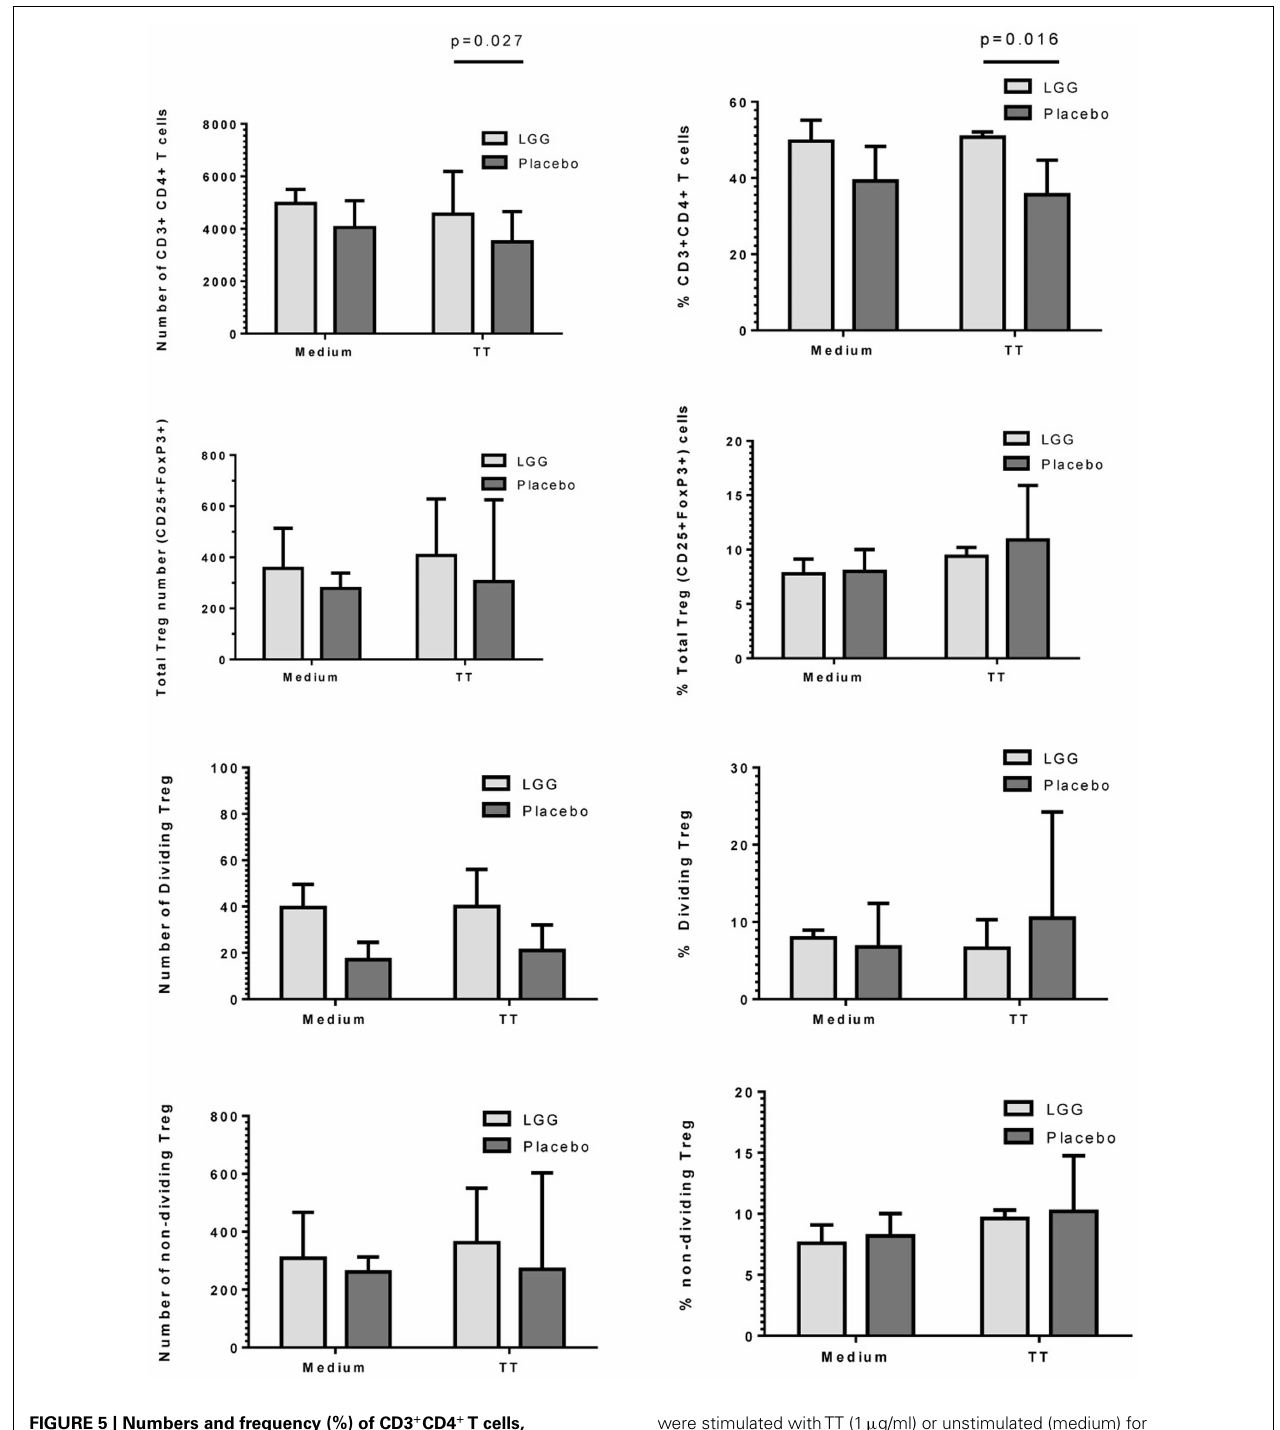
FIGURE 5 | Numbers and frequency (%) of CD3 + CD4 + T cells, total CD4 + CD25 + FoxP3 + Treg, dividing (CFSE lo ), and non-dividing (CFSE hi )Treg identified in PBMCs isolated from infants in the LGG ( N = 31) or Placebo ( N = 30) groups . PBMCs (1 × 10 6 /ml)